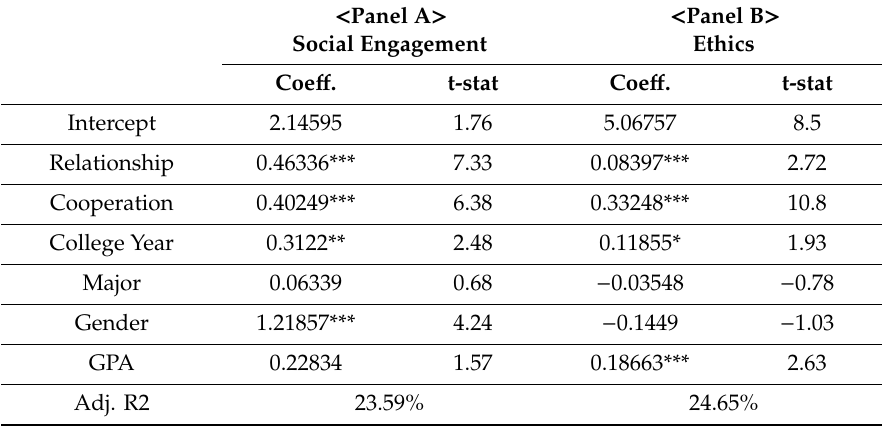
Table 6. E ff ects of Solidarity on CSV.